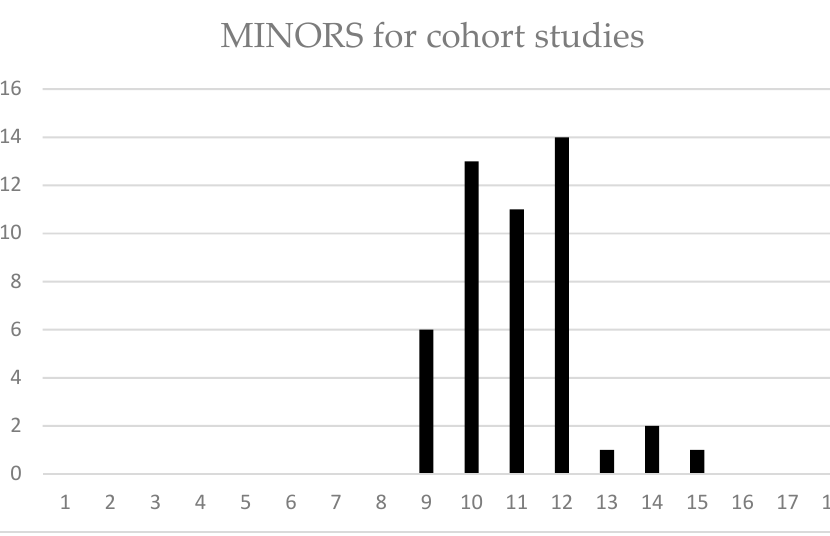
Figure 3. MINORS scores for cohort studies.